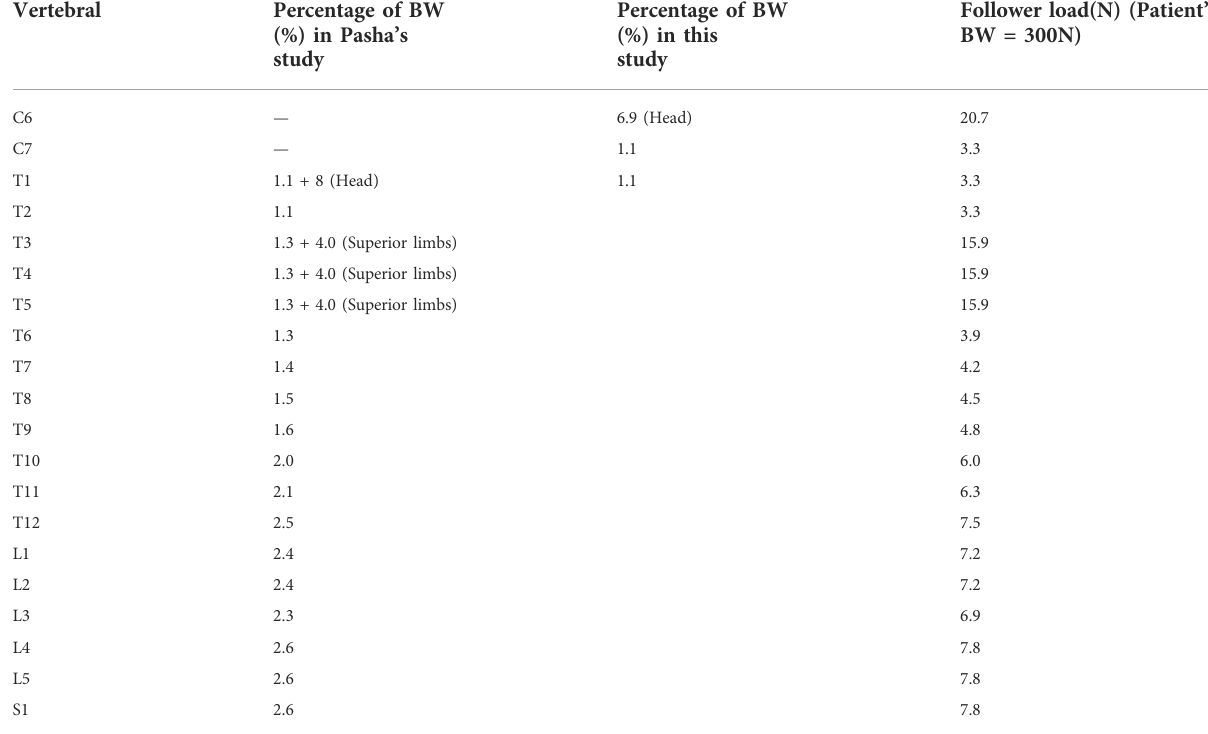
TABLE 2 The follower load of C6-S1 spinal segments (Pasha et al., 2014).